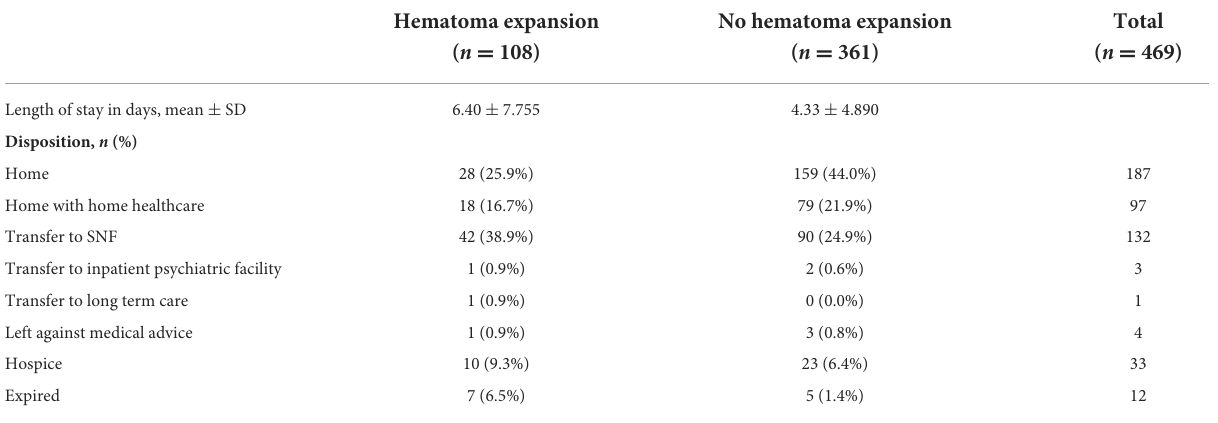
TABLE 4 Discharge disposition in relation to hematoma